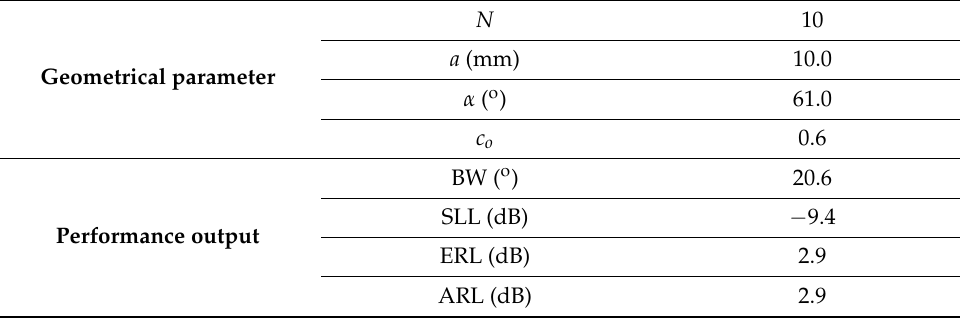
Table 3. Structure of the optimized GFA model.